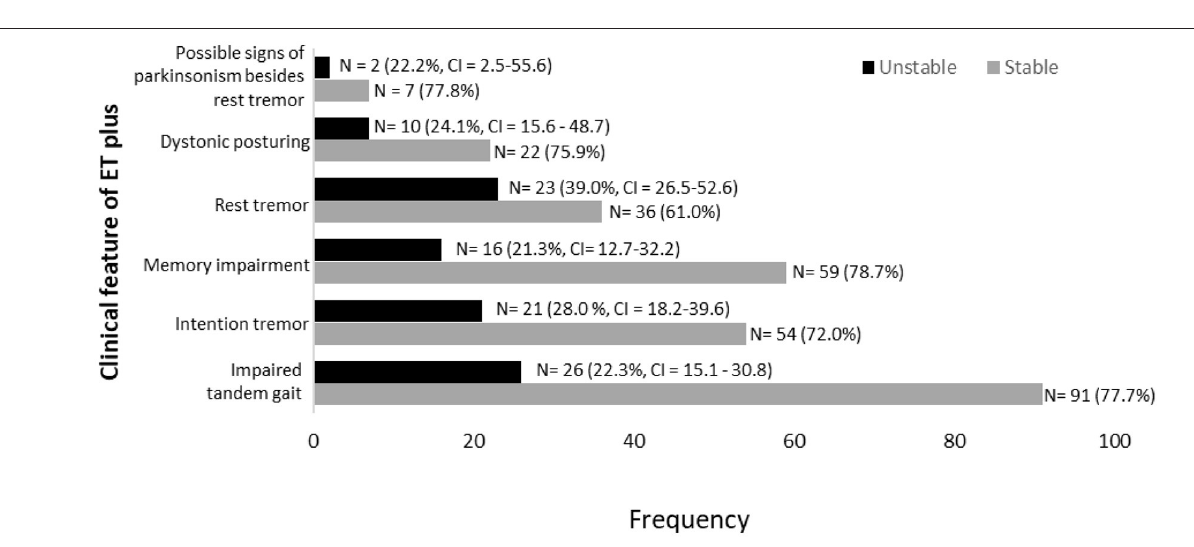
FIGURE 5 | Stability of ET plus diagnostic criteria in 172 participants labeled with ET plus in at least one time